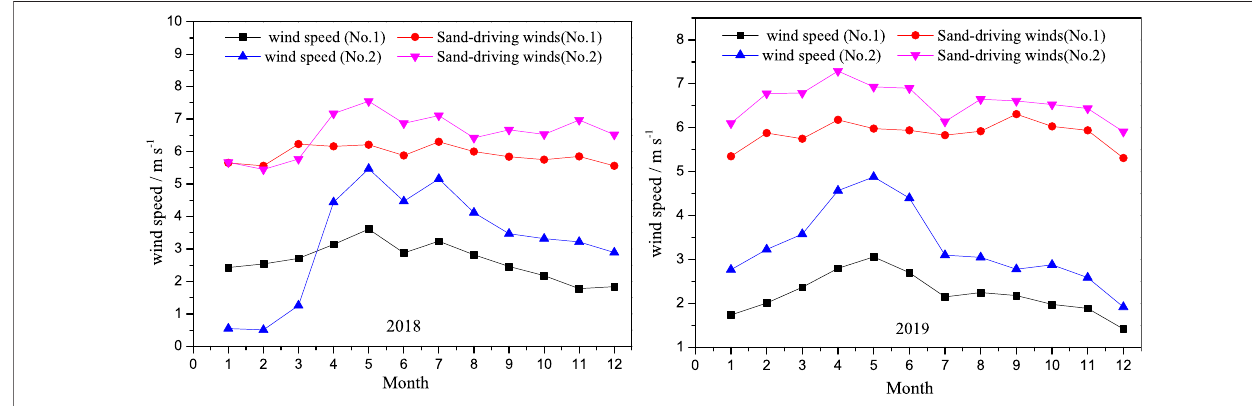
FIGURE 4 | Monthly wind speed and sand-moving wind at sites No. 1 and No. 2 in 2018 and 2019.